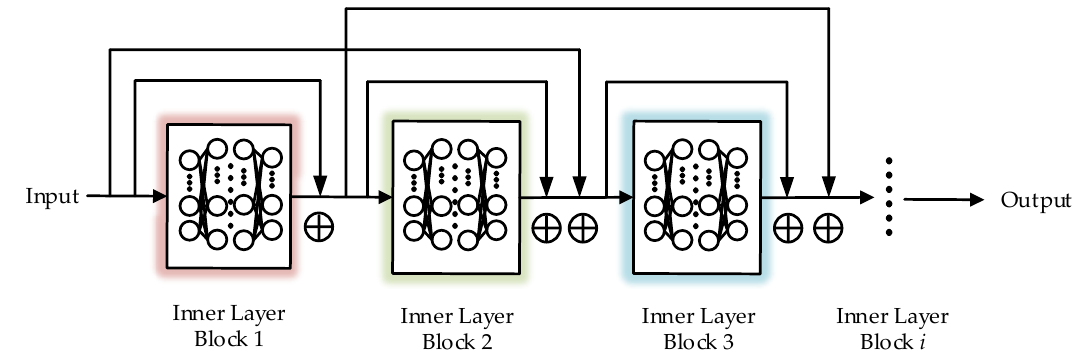
Figure 6. The structure of locally cumulative connected deep neural networks.